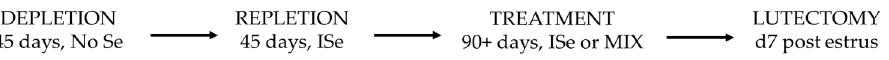
Figure 1. Experimental model of dietary supplementation. At the start of experimentation, cows were subject to a 45-day depletion during which they were supplemented with a Se-free vitamin- mineral mix, followed by a 45-day repletion period during which cows were supplemented with a vitamin-mineral mix formulated to contain 35 ppm ISe/cow/day. After repletion, cows were supplemented with a vitamin-mineral mix containing 35 ppm of their respective treatment for at least 90 days prior to estrous synchronization with an i.m. injection of 25 mg dinoprost tromethamine. On day 7 post-estrus, CL were collected via trans-vaginal lutectomy for analysis of key selenoprotein- encoding and steroidogenic transcripts by real-time PCR and in vitro culture of dissociated luteal cells with select agonists.